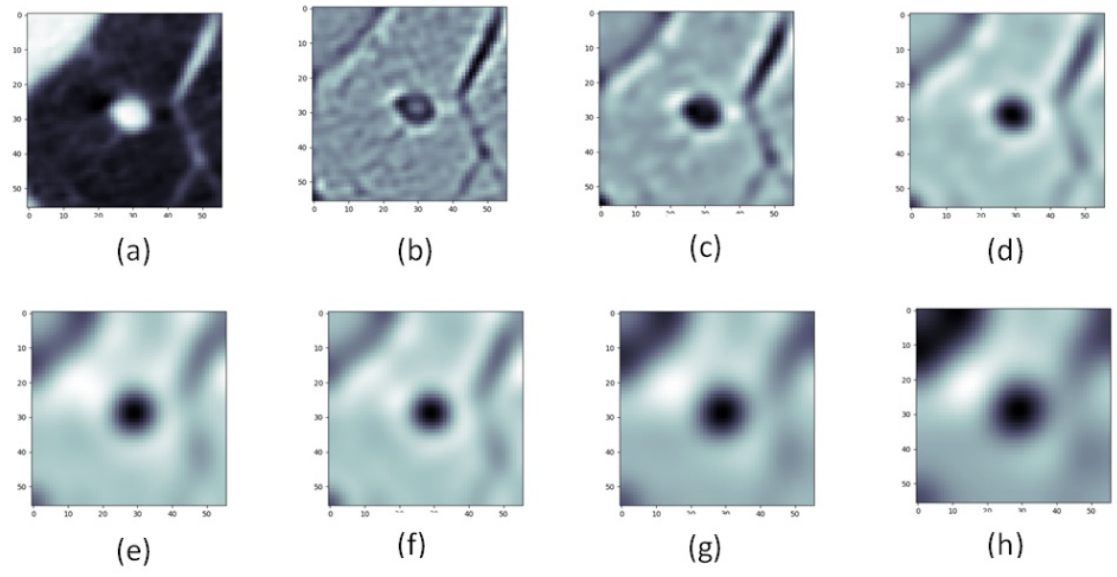
Figure 8. ( a ) Raw nodule, ( b ) through ( h ) are LoG filtered nodule with σ = 1 to σ = 7 1 by 1 incremental.